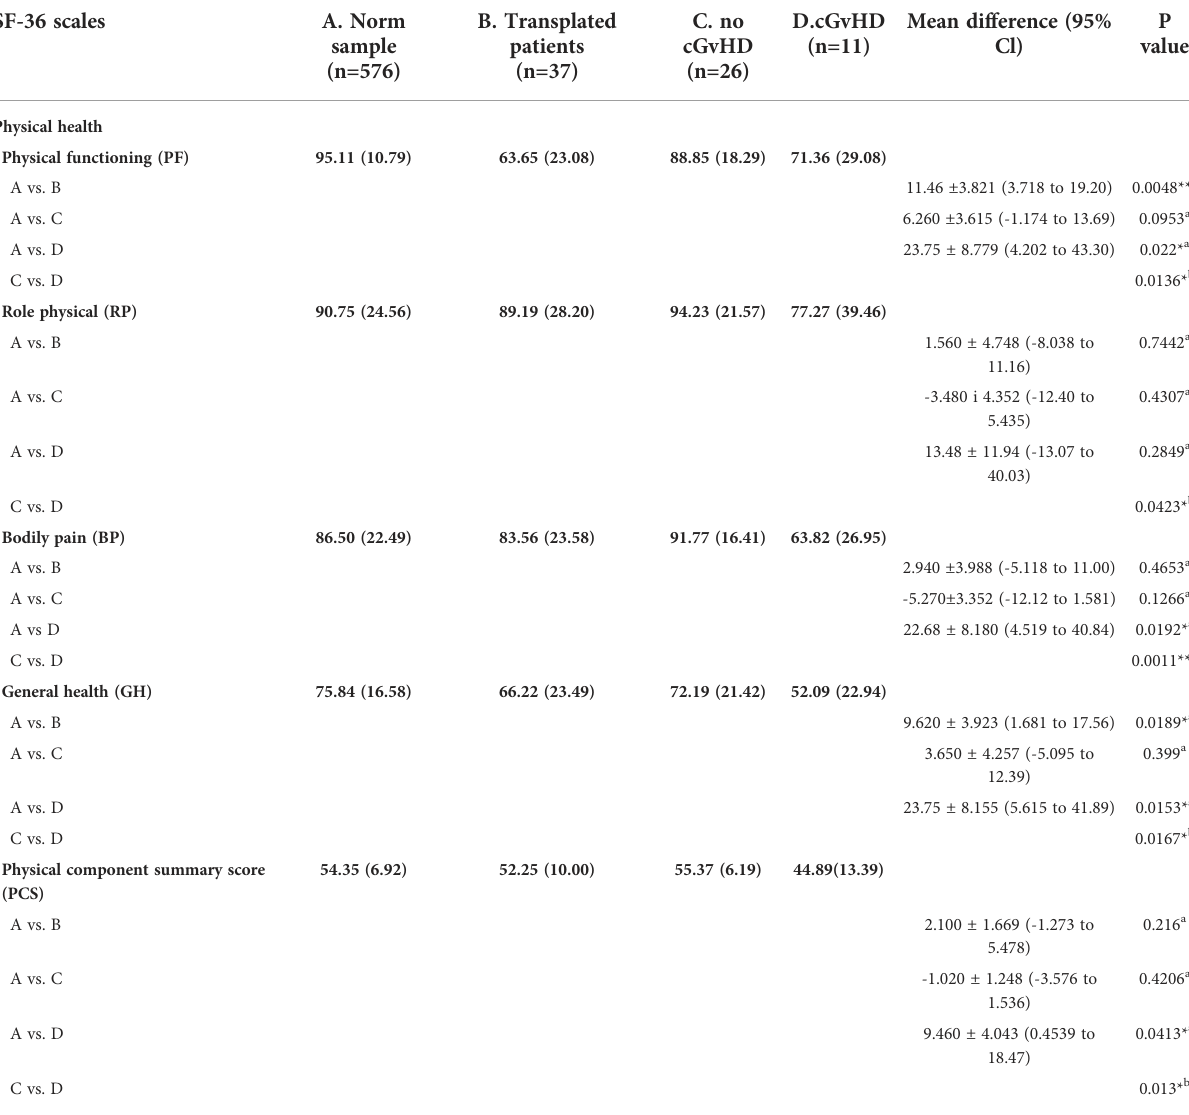
TABLE 1 Physical health as scored by the SF-36 questionnaire and level of signi fi cant differences in participants with and without GvHD. and in comparison to the norm